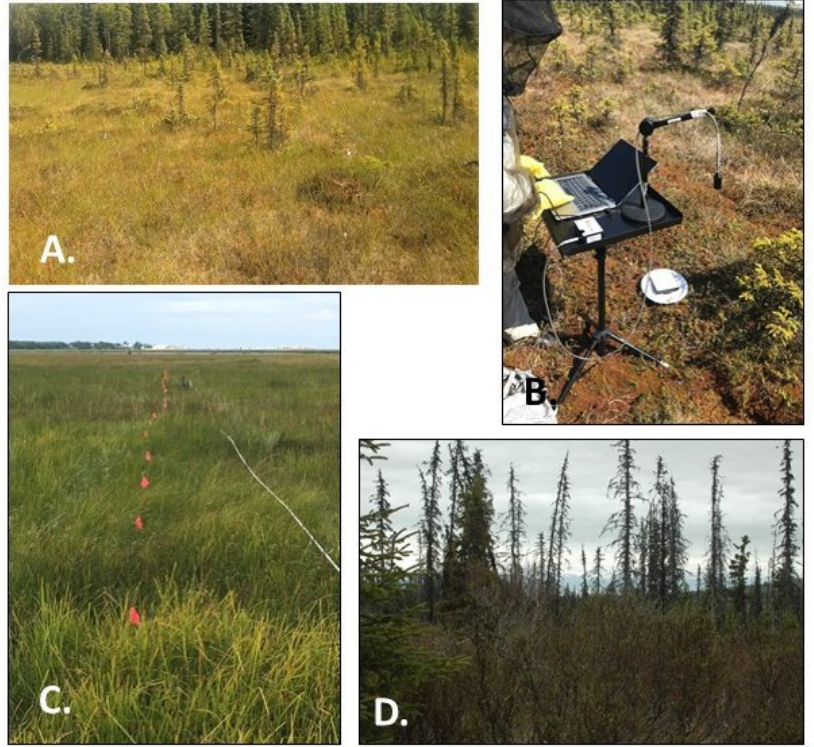
Figure 2. Images illustrating the four wetland classes sampled for this research. ( A ). Sedge Peatland (Beaver Creek) ( B ). Low Shrub (Lily Lake) with the spectrometer set up ( C ). Wet Herbaceous (Bridge Access Road) with transect flags ( D ). Black